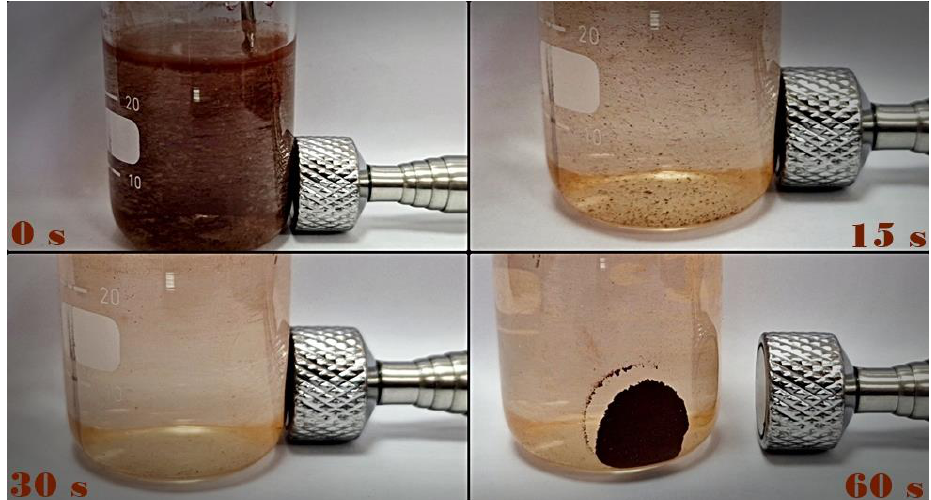
Figure 7. Suspension of 12ZrO 2 /Fe 3 O 4 (1.67 mg/cm 3 ) photocatalyst at selected time intervals throughout the application of an external magnetic field.